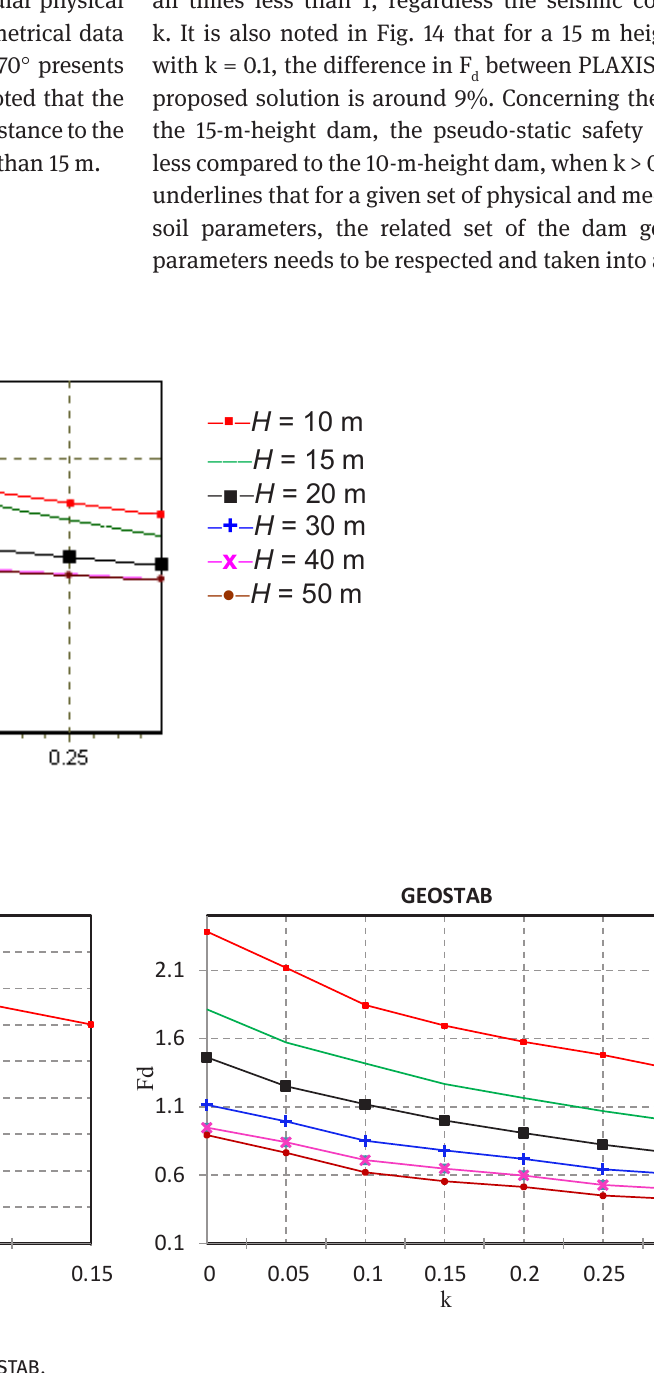
Figure 14: Effect of dam’s height with PLAXIS and